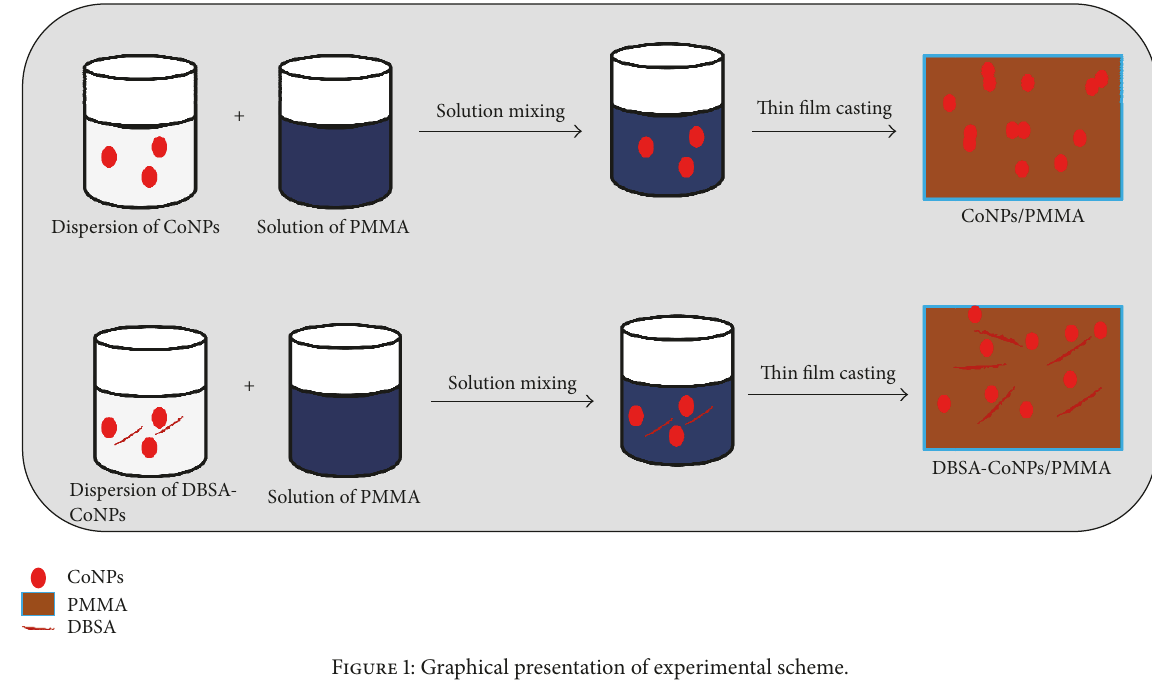
Figure 1: Graphical presentation of experimental scheme.